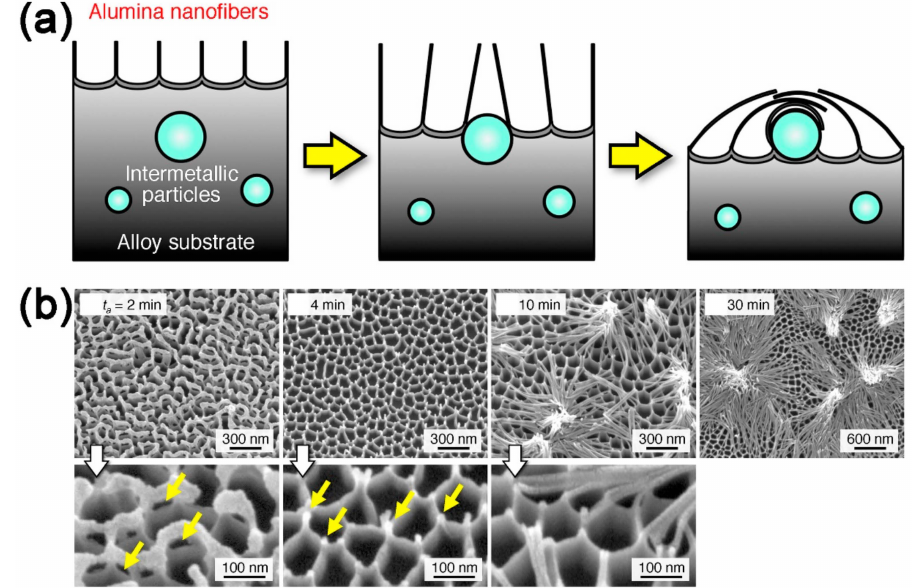
Figure 3. ( a ) Growth process of anodic aluminum nanofibers and nanofiber-tangled intermetallic particles; ( b ) SEM of samples anodized for t a = 2 min, 4 min, 10 min, and 30 min, respectively.